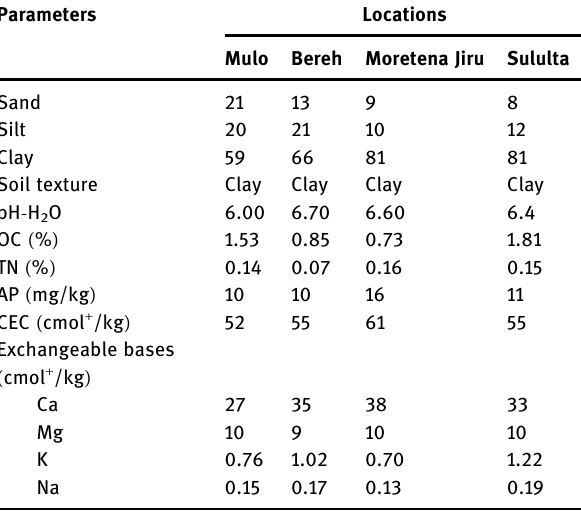
Table 1: Selected chemical and physical properties of the four study sites sampled in 2015 before planting from central Ethiopian highlands Parameters